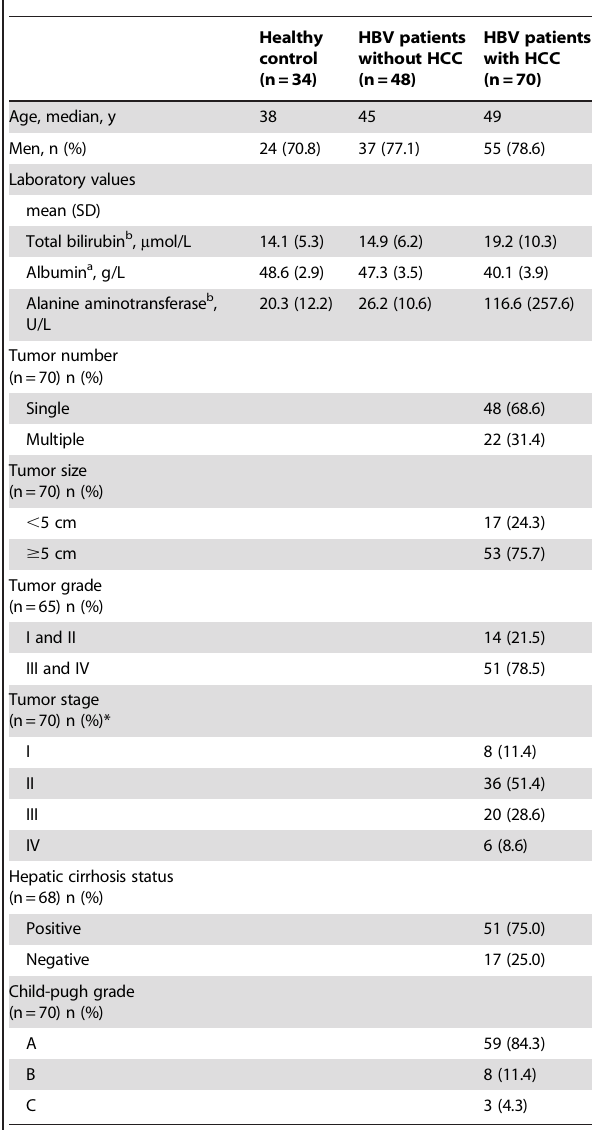
Table 1. Summary of clinical details of subjects used for miRNA